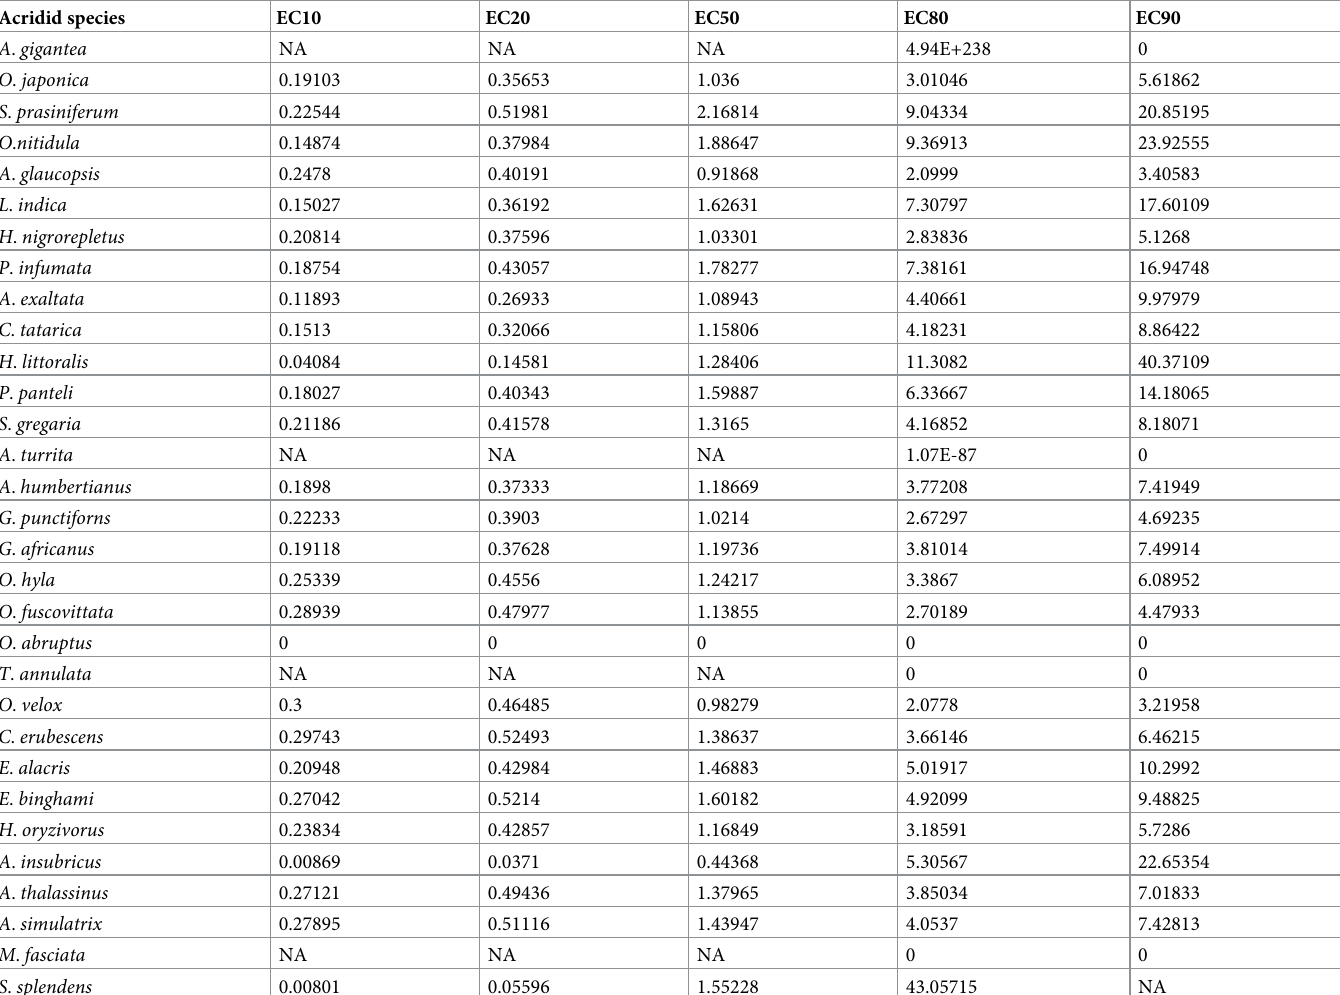
Table 2. Calculated effective concentrations (EC) for acridid species (n = 31).